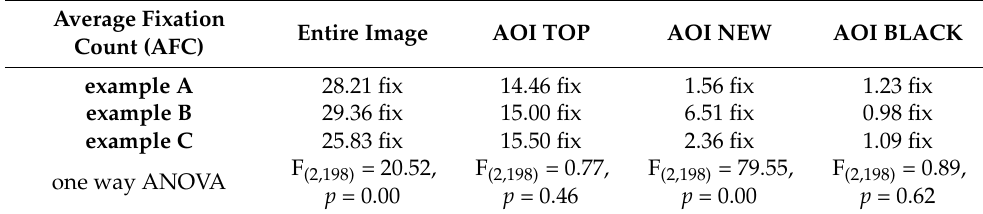
Table 2. Average fixation count (AFC) for four areas of interest.